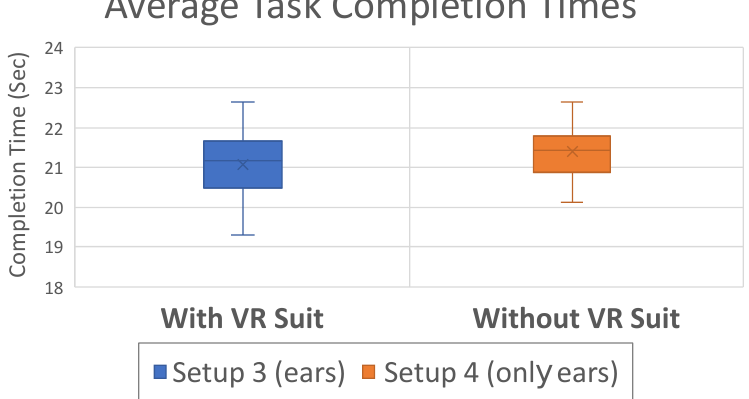
Figure 12. Average task completion times of “Setup 3 (ears)” and “Setup 4 (only ears)”. Figure 13 shows the average responses to questions about discomfort scores and the desire to use “Setup 3 (ears)” and “Setup 4 (only ears)”. Comparison of the average discomfort level of “Setup 4 (only ears)—without the VR suit” with that of “Setup 3 (ears)— with the VR suit” using the Wilcoxon test showed significant differences between these two setups ( Z = − 2.809, p = 0.005); participants rated “Setup 4 (ears only)” as more comfortable than “Setup 3 (ears)”.